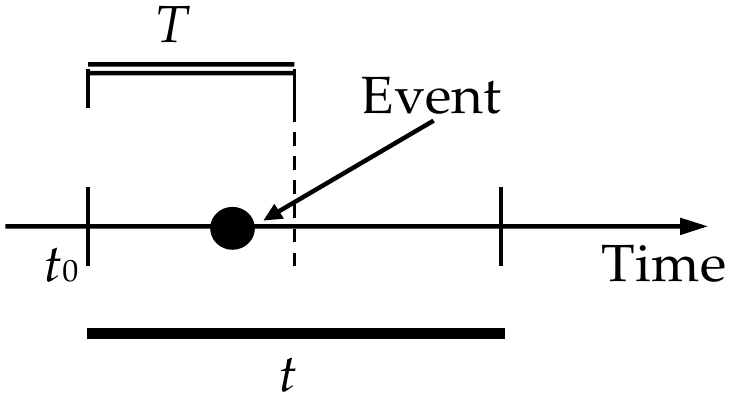
Figure 1. Fulfilment of a random event in time-interval T < t.